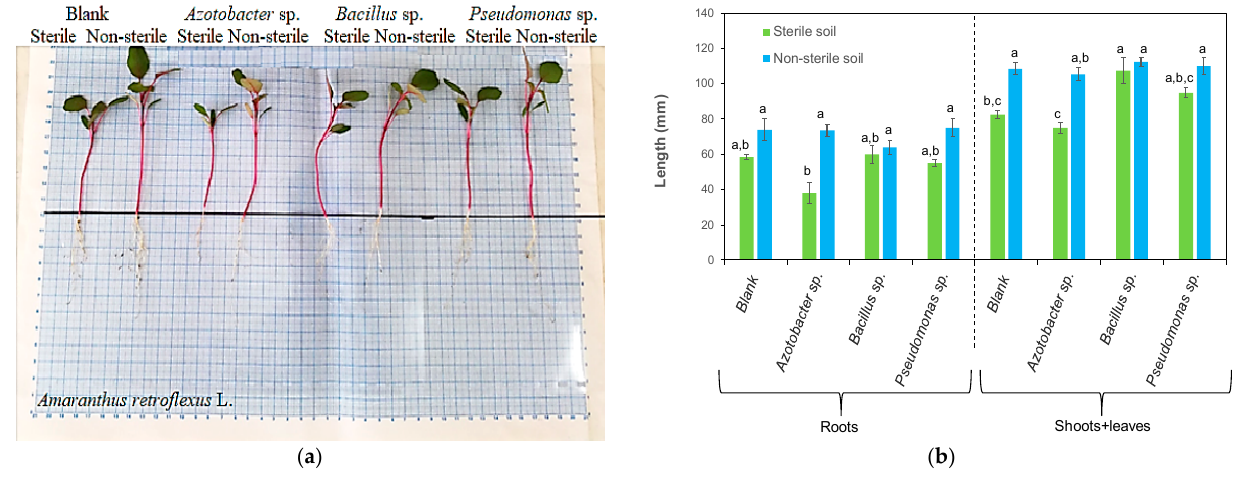
Figure 5. Effects of Azotobacter , Bacillus and Pseudomonas species on Amaranthus retroflexus L.: ( a ) visual aspect of plants and ( b ) the root and shoot/leaf length (error bars represent the experi- mental error; means that do not share a letter are significantly different according to the Tukey’s HSD test).